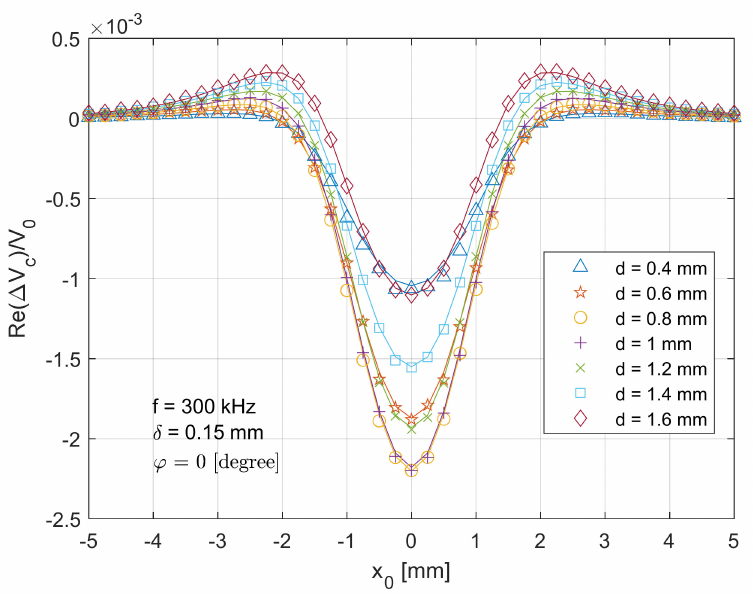
Figure 5. Comparison of analytical (lines) and experimental (markers) results for the real part of normalised voltage change (due to the crack) for the T-R sensor (tilt angle ϕ = 0 degree) scanning across ( x direction in Figure 2) and through the crack